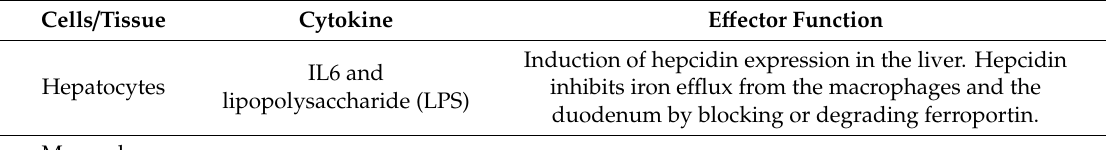
Table 1. Features of anemia of inflammation [17].